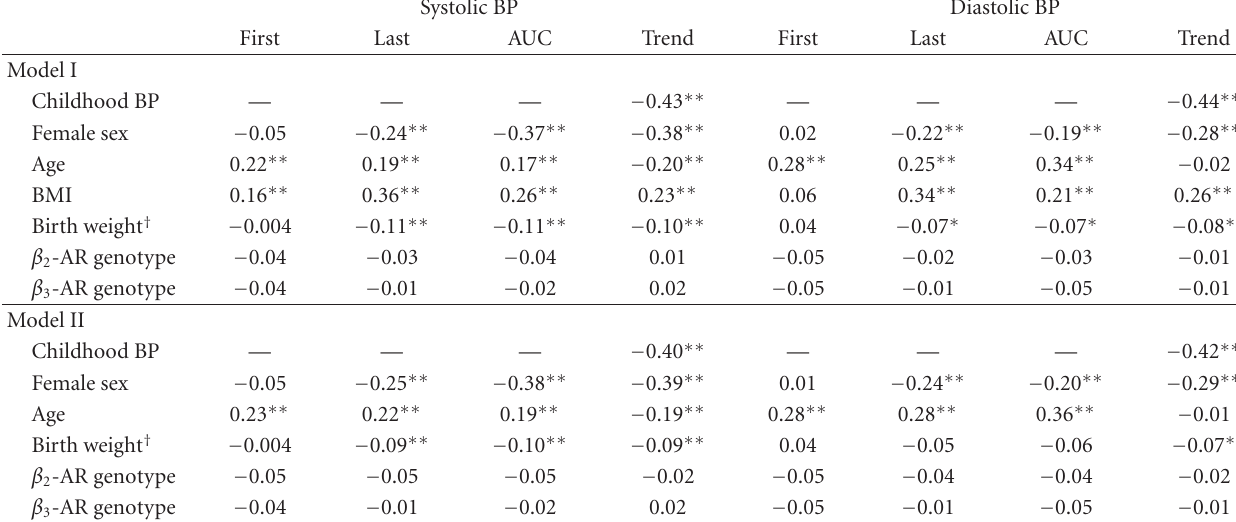
Table 2: Standardized regression coe ffi cients of race-adjusted blood pressure on birth weight, β -adrenergic receptor genotypes, and